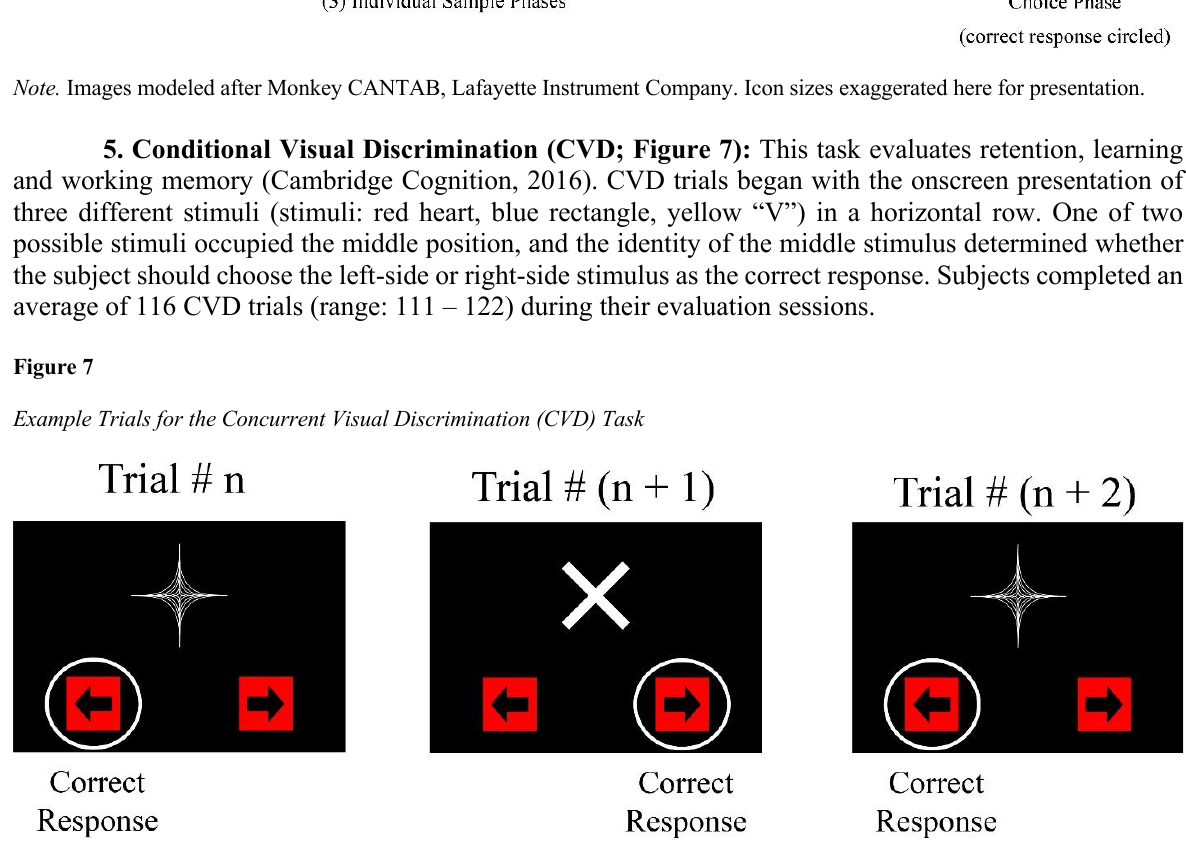
Note . Images modeled after Monkey CANTAB, Lafayette Instrument Company. Icon sizes exaggerated here for